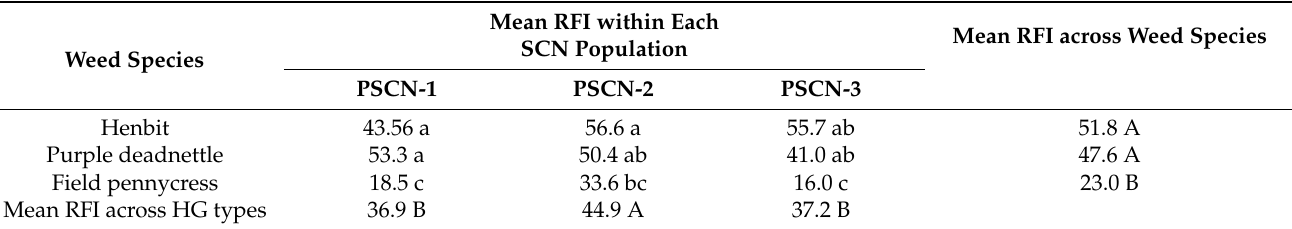
Table 4. Effect of weed species and soybean cyst nematode (SCN) populations on the female index under greenhouse